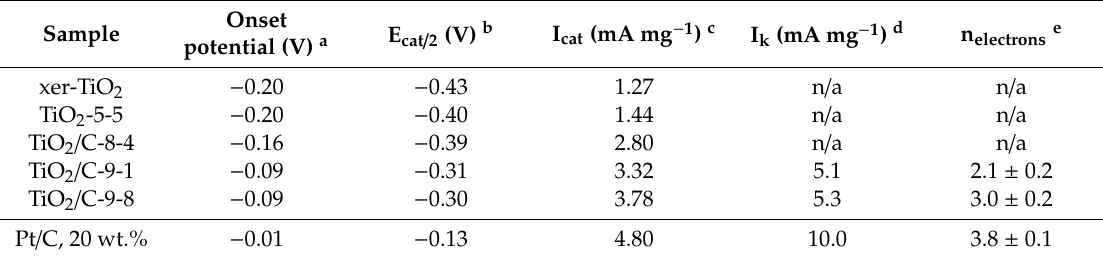
Figure 7. ( a ) Cyclic voltammogram measured for TiO 2 / C-9-1 in O 2 -saturated 0.1 M KOH solution at a scan rate of 100 mV s − 1 . ( b ) Polarization curves measured in O 2 -saturated 0.1 M KOH solution, at a scan rate of 10 mV s − 1 , and a rotation rate of 1600 rpm for xer-TiO 2 , TiO 2 -5-5 and the TiO 2 / C- x - y series. ( c ) Polarization curves measured in O 2 -saturated 0.1 M KOH solution (solid lines) for TiO 2 / C-9-1 at di ff erent rotation rates from 600 to 2600 rpm, at a scan rate of 10 mV s − 1 . The dashed lines are the polarization curves measured in Ar-saturated 0.1 M KOH solution, at a scan rate of 10 mV s − 1 and a rotation rate of 1600 rpm. ( d ) Koutecky–Levich plots obtained for TiO 2 / C-9-1 (colored dashed lines) and TiO 2 / C-9-8 (colored solid lines) at di ff erent voltages (from − 0.45 to − 0.55 V vs. Ag / AgCl). The dotted lines correspond to the ideal two electrons process (n = 2) and four electrons process (n = 4). Table 2. Electrochemical properties towards the ORR in 0.1 M KOH of xer-TiO 2 , TiO 2 -5-5 and the di ff erent TiO 2 / C- x - y samples studied herein. Comparison with a commercial Pt / C, 20 wt.%,